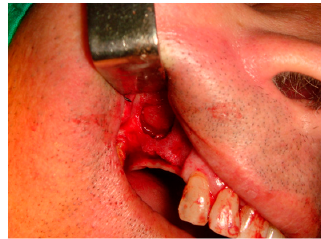
Figure 5. A lateral window is prepared and the Schneiderian membrane is elevated.